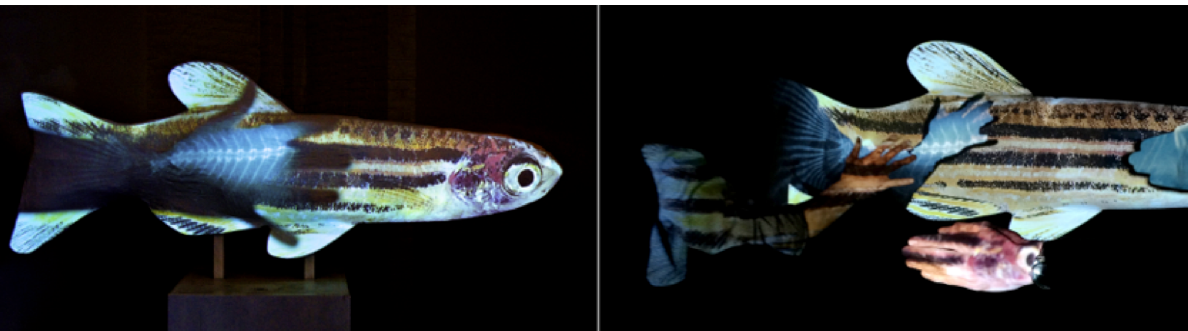
Figure 2 | The augmented zebrafish (length approximately 1,75 m). The fish’s skin is projected on a physical model. The shadows of the viewers reveal the inside of the fish (X-ray view). Image courtesy of Marcello Gómez Maureira and Carolien